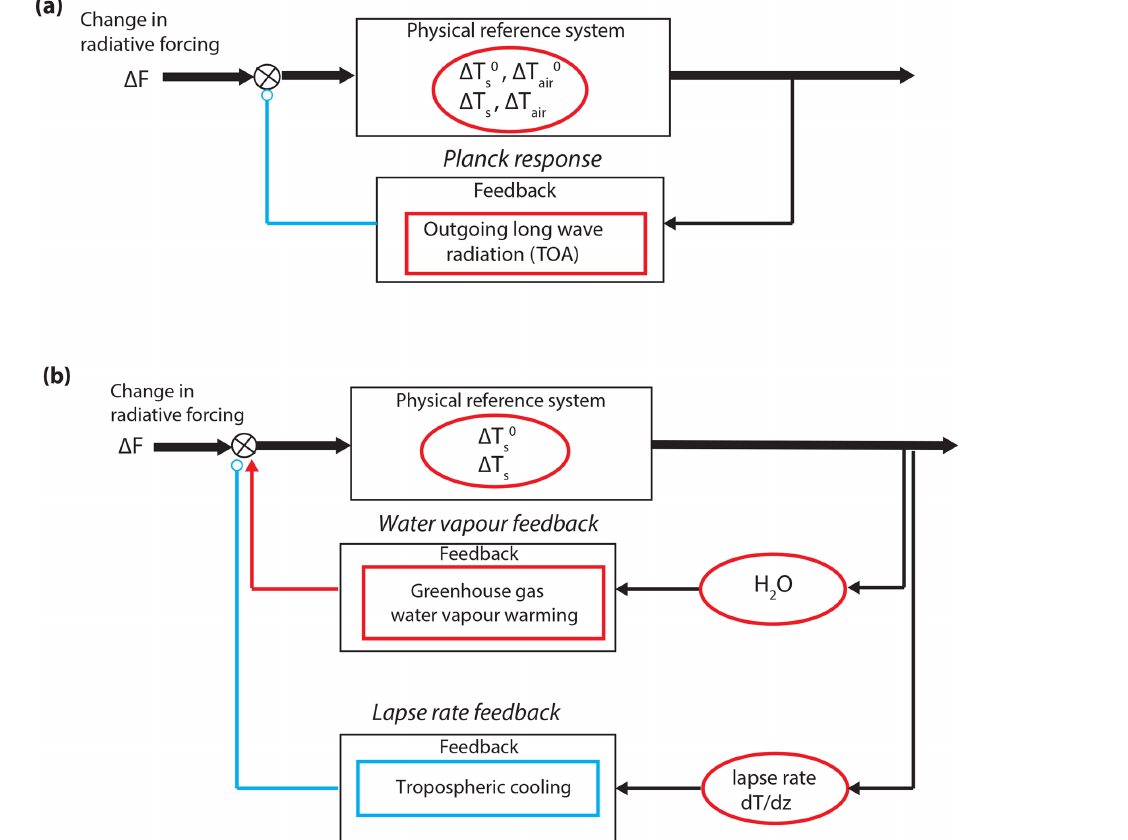
Figure 5. (a) Negative Planck response feedback. (b) Combined water vapour lapse rate feedback. Arrows indicate positive coupling; open circles indicate negative coupling. Changes in state variables are indicated in ellipses. The combined water vapour lapse rate feedback is still positive. Red indicates increasing variable values, strengthening of processes, or positive feedback; blue indicates the opposite. The temperature change (cid:49)T in the presence of feedback is different from the change (cid:49)T 0 without